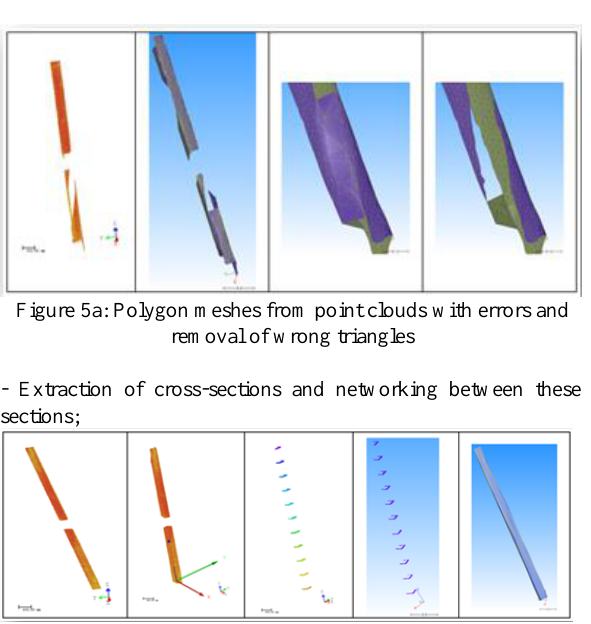
Figure 5b: Manual profile extraction and polygon meshes - Extraction of cross-sections and calculation of mean planes between each profile (Figure 5c);